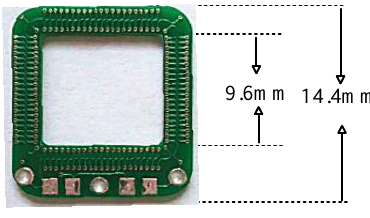
Figure 8. A PCB Rogowski coil.